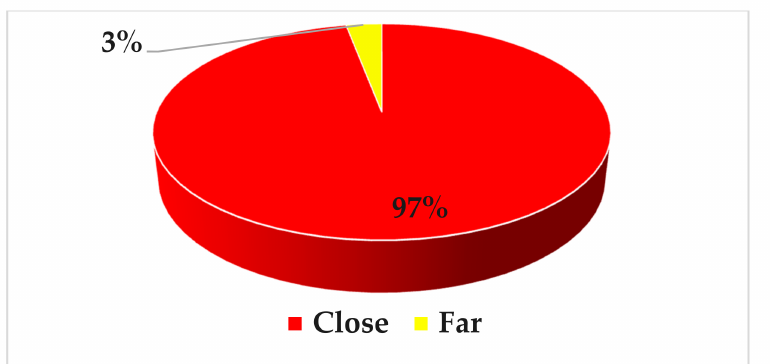
Figure 10. Characteristics of respondents based on distance of their residence from BCMH.